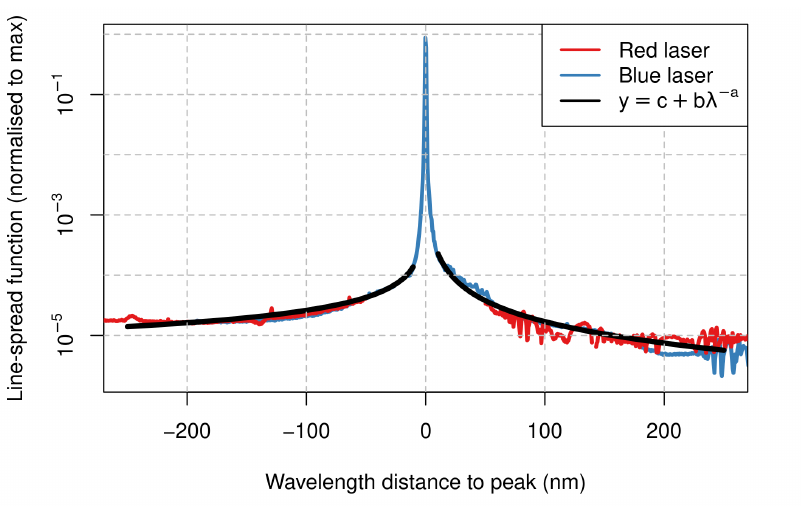
Figure 5. Line-spread function from the red and blue lasers recorded by the array spectrometer. The region close to the red laser peak ( ± 50 nm) was removed due to a double diffraction. Each tail was fitted independently using the formula in the